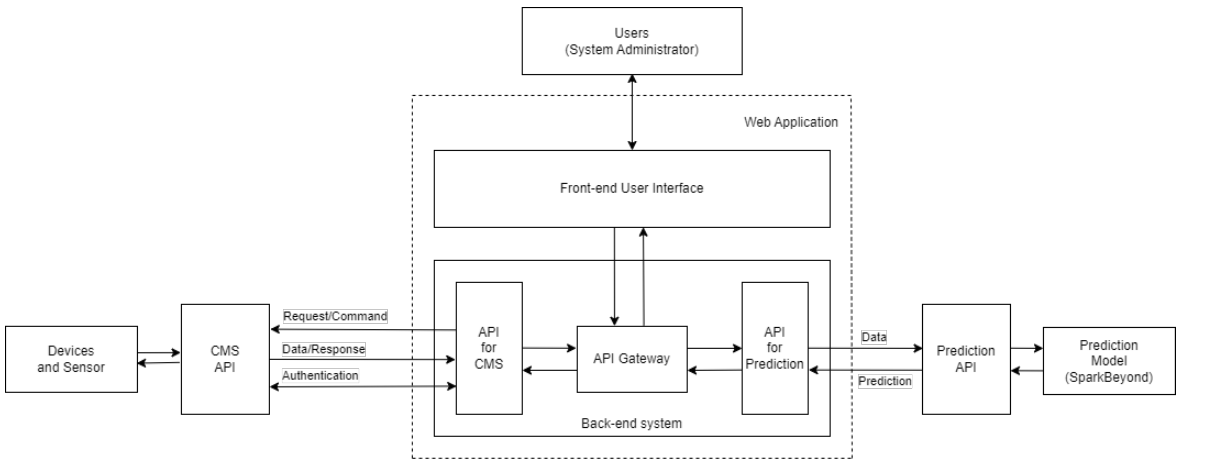
Figure 3. The overview diagram of the process in the smart street lighting web application